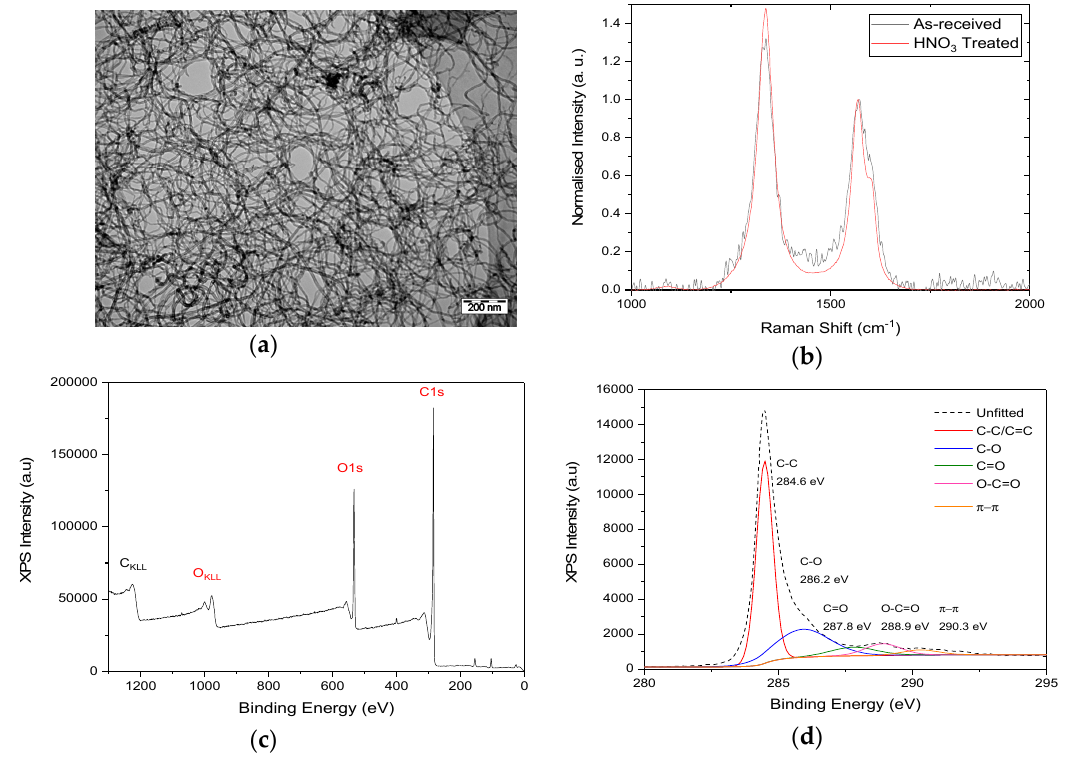
Figure 1. Characterisation of f-MWCNTs. ( a ) TEM of f-MWCNTs; ( b ) Raman spectra of as-received and functionalised MWCNTs; ( c ) Survey XPS scan of f-MWCNTs; ( d ) XPS spectrum of C1s region from f-MWCNTs.